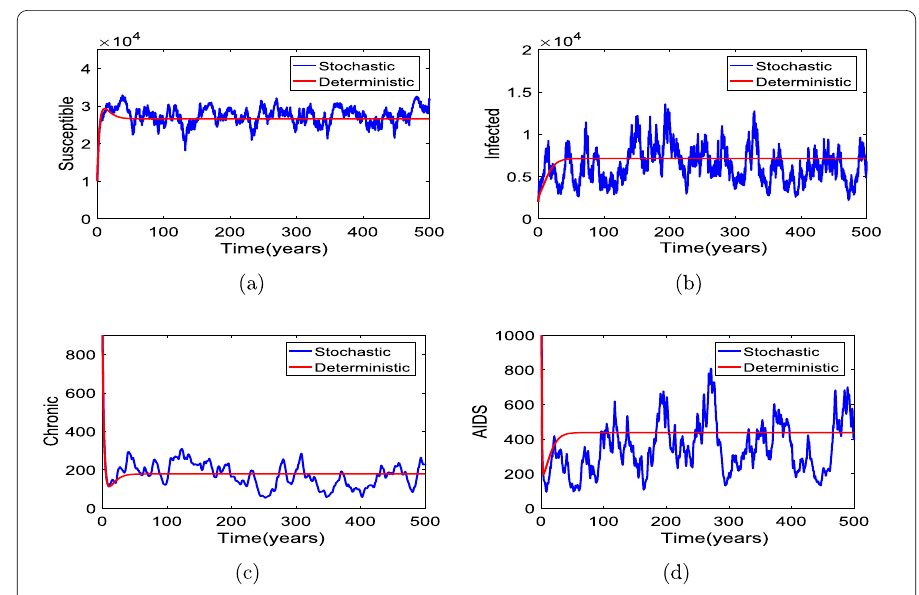
Figure 5 The path S ( t ), I ( t ), C ( t ), and A ( t ) for models (1.1) and (1.2), when R 3 = 1.163 > 1 and R 0 = 1.291 > 1